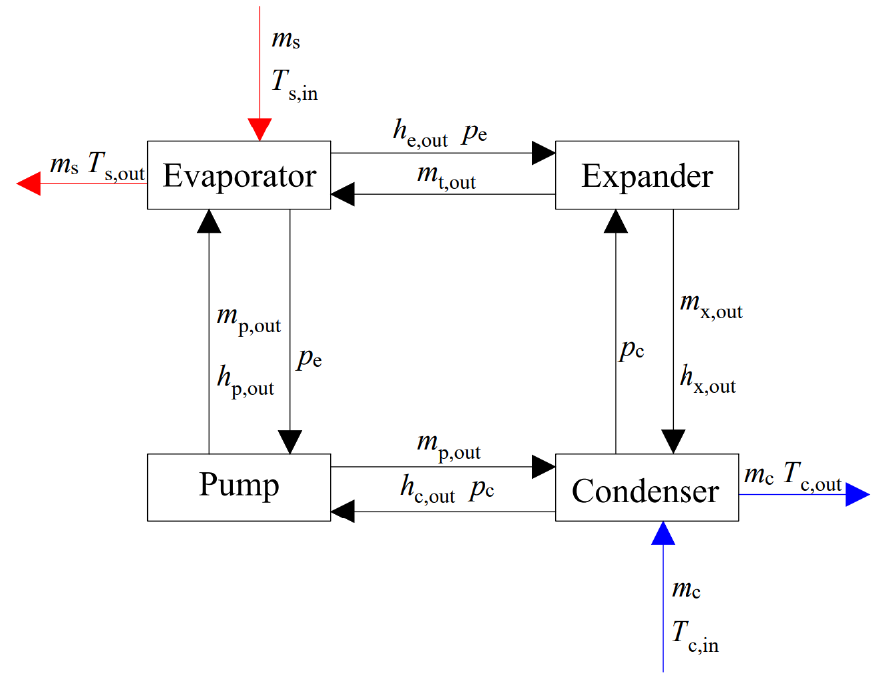
Figure 5. Relationship between the input and output parameters of each module in the ORC system.